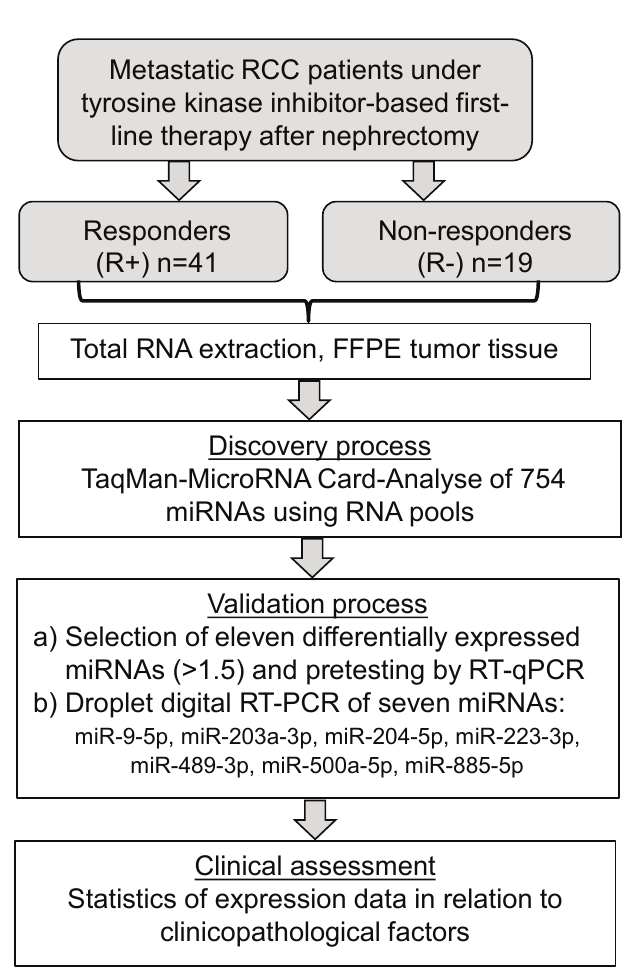
Figure 1. Flowchart of the study. Abbreviations: FFPE, formalin-fixed, paraffin-embedded; RCC, renal cell carcinoma; RT-qPCR, reverse transcription real time quantitative polymerase chain reaction; TKIs, tyrosine kinase